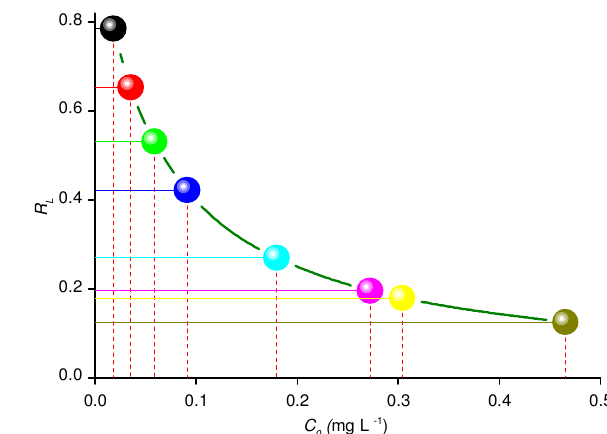
Fig. 9: The Adsorbed Separation Factor of As (III) on Shikarap Ore (Adsorbent Dose 0.5 g Per 50 ml, pH 6, Shaking Time 2hrs, Temp: 25 ± 2 O